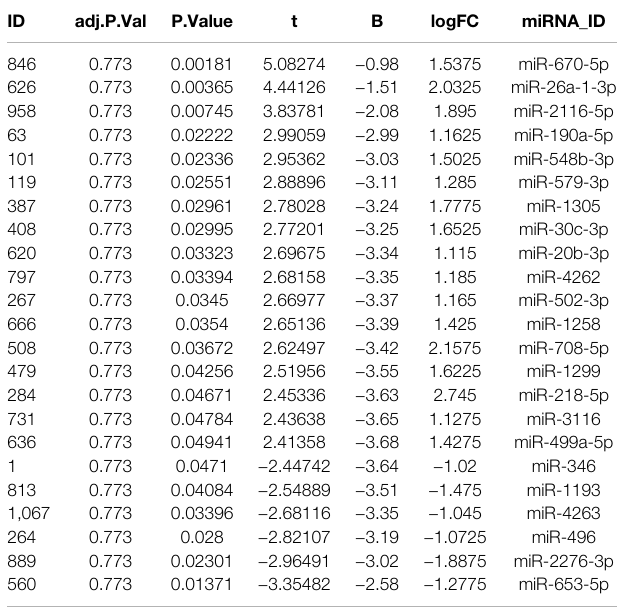
TABLE 6 | differentially expressed miRNAs (DEMs) obtained from the